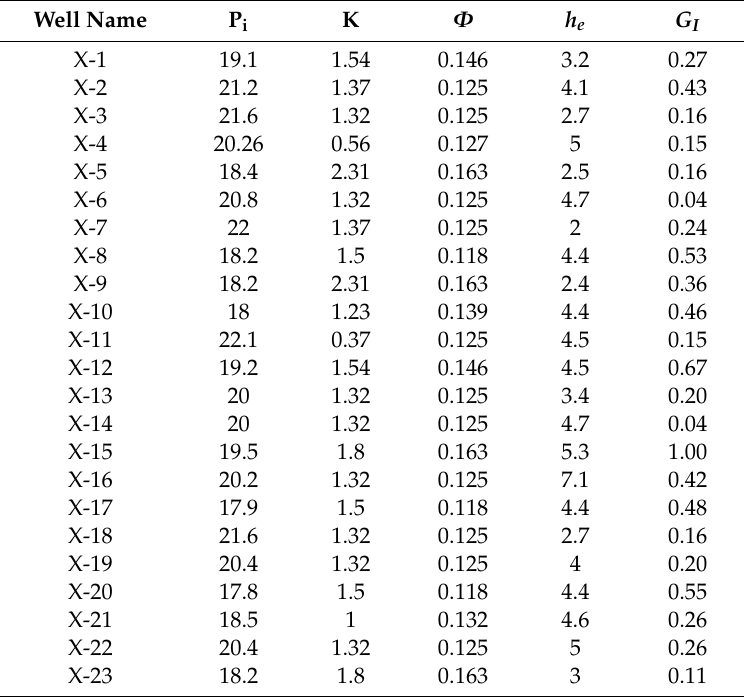
Table A1. Statistical table of geological parameters of tight oil wells in the target block.